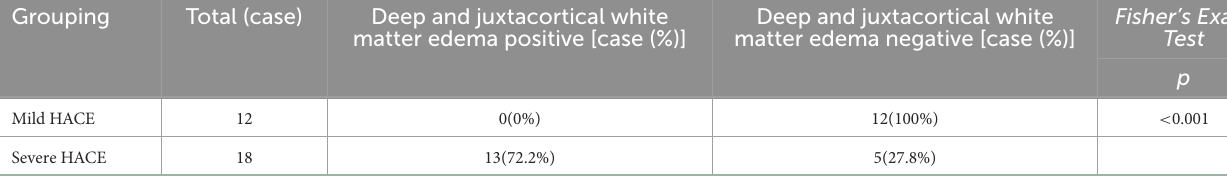
TABLE 4 Distribution of deep and juxtacortical white matter edema in 30 HACE. Grouping